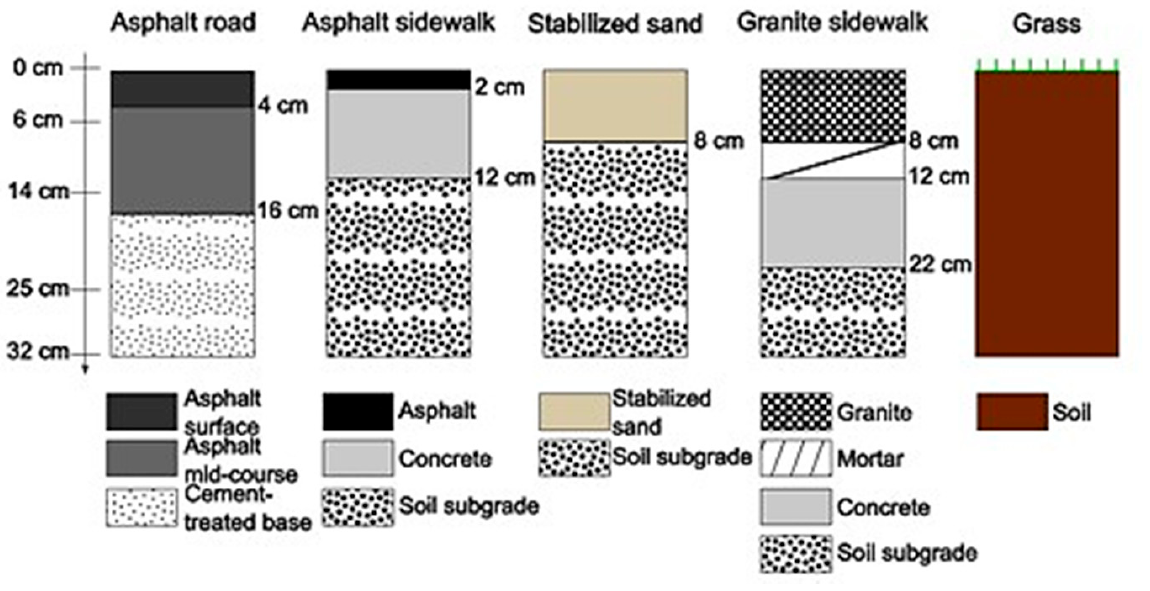
Figure 7. Structure of studied pavement samples [115].